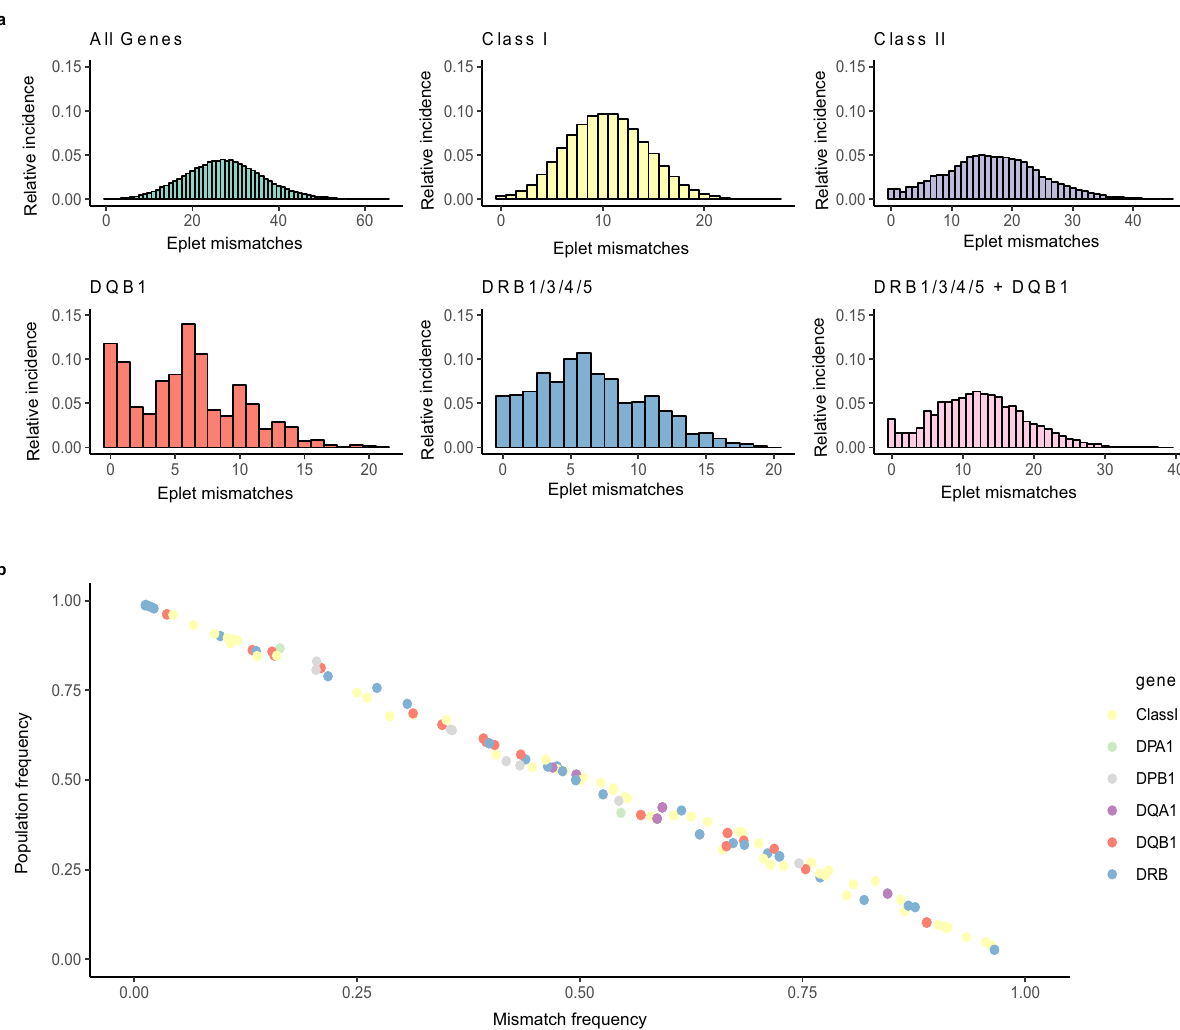
Fig. 7 The eplet mismatch distribution in the study population. 1049 kidney patients were matched against 243 deceased donors by blood-group identity. Next, eplet mismatches across all 11 HLA genes ( HLA-A, -B, -C, -DRB1, -DRB3, - DRB4, -DRB5, -DPA1, -DPB1, -DQA1 , and -DQB1 ), class I genes, class II genes, DQB1 only, DRB1/3/4/5 , and DRB1/3/4/5 and DQB1 were calculated. A mismatch was determined as an eplet present in a donor that is not present in the patient. a Distribution of the relative incidences of eplet mismatch scores at all gene combinations analyzed. Relative incidence is the proportion of a particular quantitative eplet mismatch out of the total number of 92,756 blood-group identical matches. b The linear correlation (Pearson ’ s) of population frequency versus mismatch frequency for individual eplets. A dot represents an individual eplet color-coded by gene combination, and all identi fi ed eplets are plotted ( n = 150). Population frequency is the proportion of individuals (kidney patients and donors) whom express the eplet, out of the total study population ( n = 1846). Mismatch frequency was the incidence of a particular eplet being mismatched in blood-group identical matches, divided by the sum of the number of donors with the speci fi c eplet multiplied by the number of patients, restricted by blood group. The correlation coef fi cient ( r ) is −